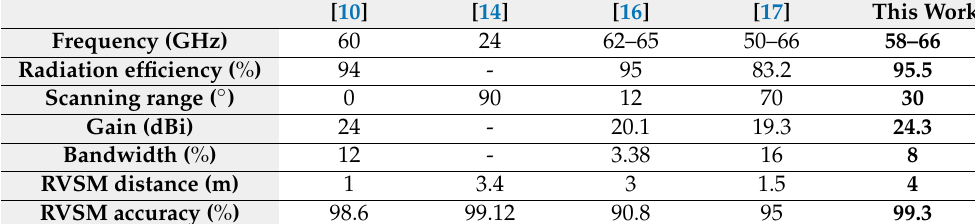
Table 3. Comparison of the proposed LWA with